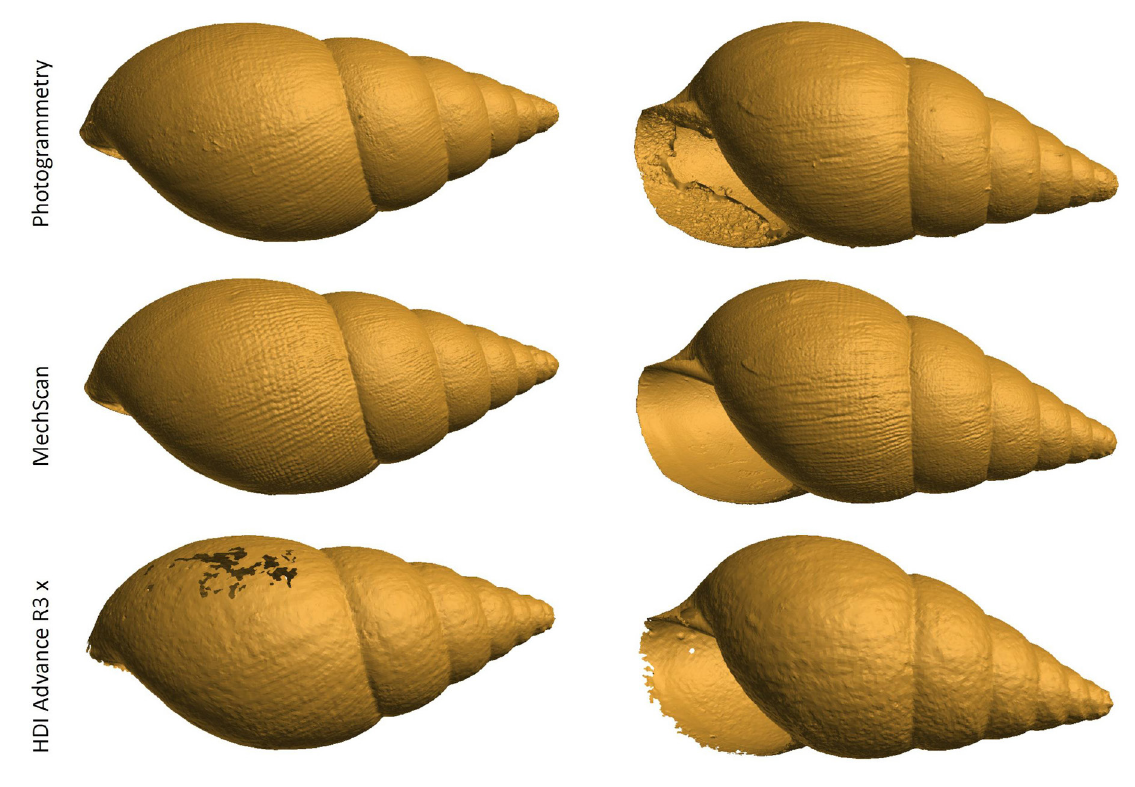
Fig. 6.1. Shell digitised with different methods. The photogrammetry model was captured with a 100 mm Macro lens and processed with Agisoft Photoscan. The visual comparison of the mollusc shows a similar level of detail between photogrammetry and MechScan for the external surfaces, with still a bit more detail for the MechScan. The HDI Advance has a much lower